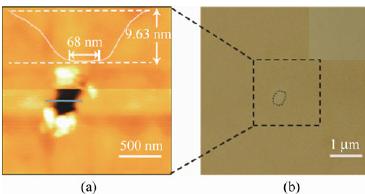
Figure 19. Images of the fabricated nanopore. ( a ) AFM image of an asymmetric ultra-thin nanopore processed with 250 nm × 250 nm scanning area on a 9.50 nm mica layer. The geometrically asymmetric height image shows the profile of the nanopore; ( b ) the same area viewed by optical microscopy. Reprinted with permission from reference [144].